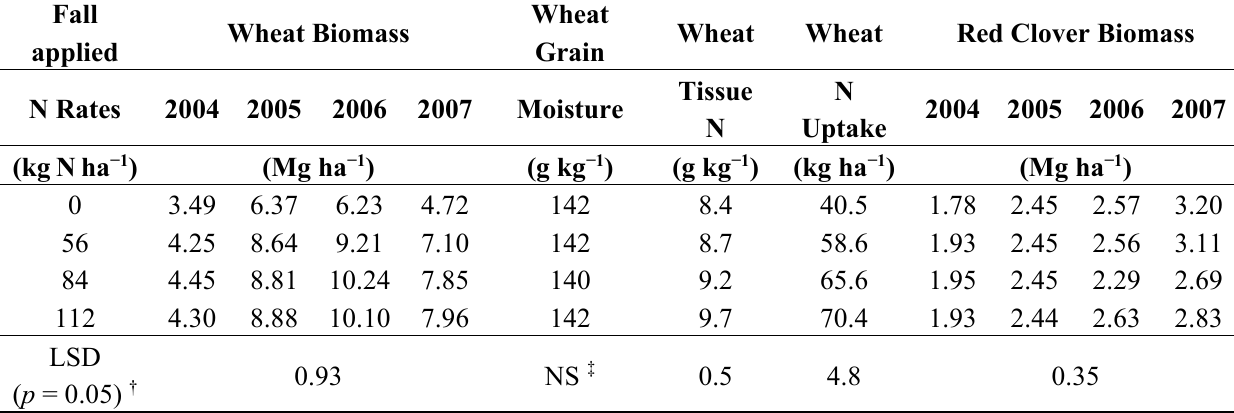
Table 3. Fall-applied nitrogen rate main effects for wheat plant biomass dry matter,